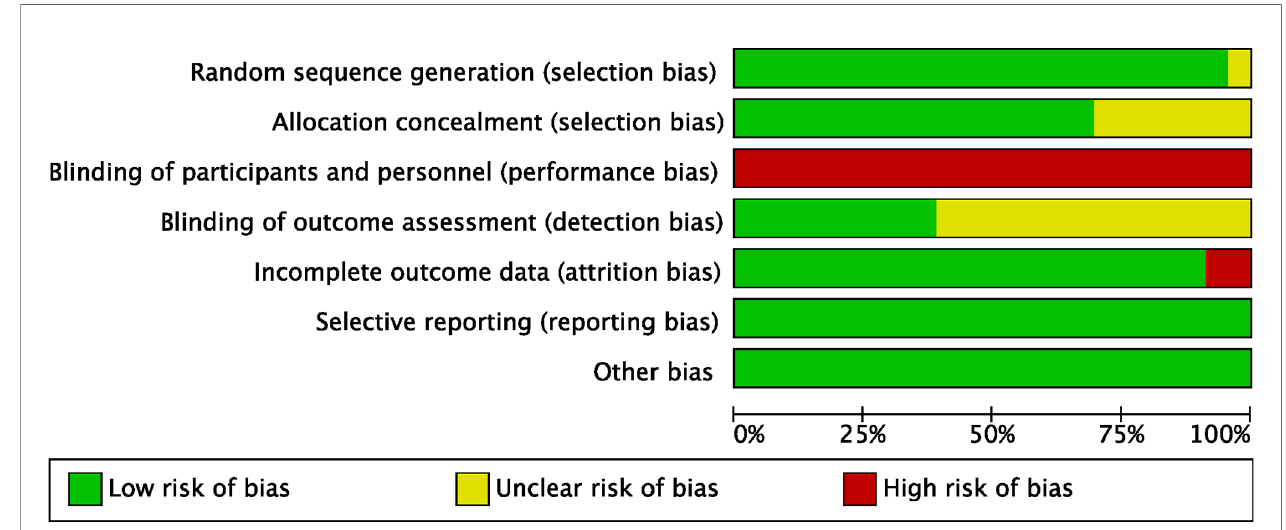
FIGURE 2 | Quality assessment of included studies using Cochrane Collaboration ’ s Risk of Bias.